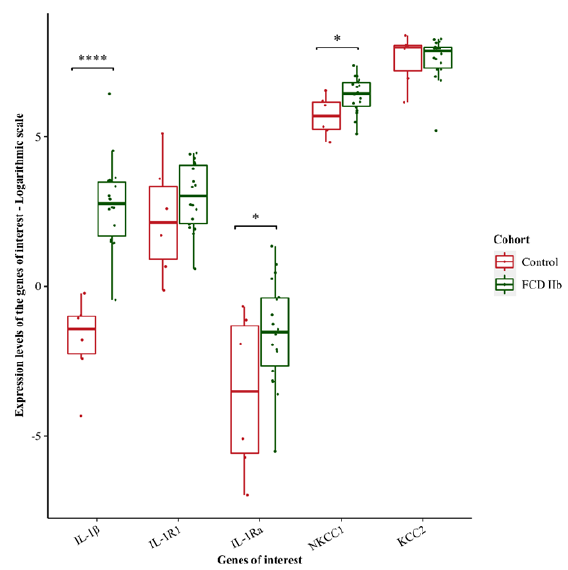
Figure 3. Expression levels of the genes of interest in FCD IIb pediatric tissue samples compared to age-matched controls . IL −1β , IL − 1Ra and NKCC1 are significantly upregulated in FCD IIb pediatric tissue samples compared to controls. Expression levels are described in logarithmic scale. * p < 0.05; **** p < 0.0001. A linear model was fit for each gene and moderated t-statistic was calculated after applying an empirical Bayes smoothing to the standard errors. Those genes with a Benjamini – Hochberg adjusted p -value < 0.05 were considered significant. Differential expression analysis com- pared 18 FCD IIb patients and six age-matched control cortices.